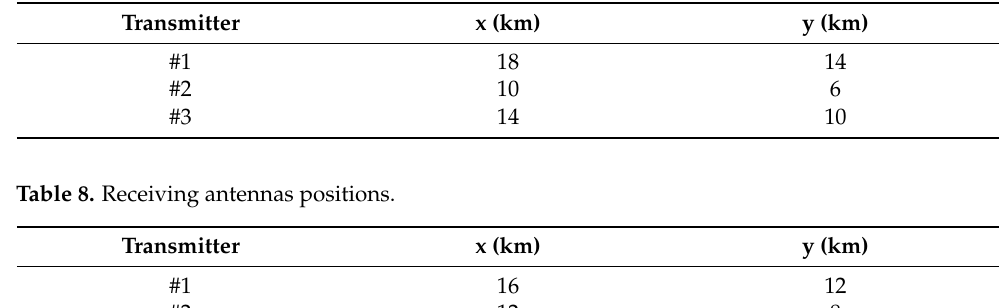
Table 8. Receiving antennas positions.